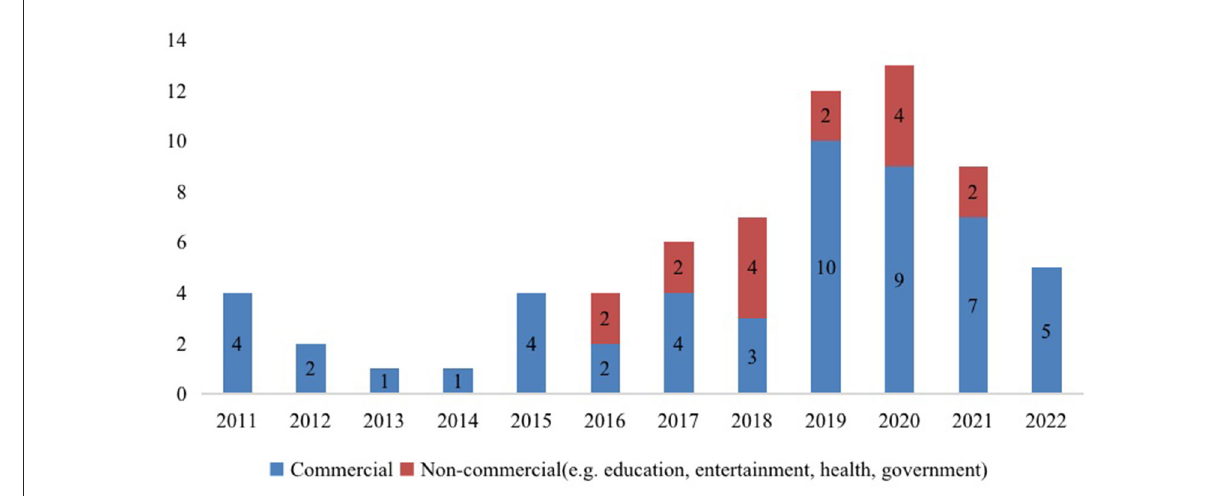
FIGURE3 Selected articles by setting (commercial vs. non-commercial).